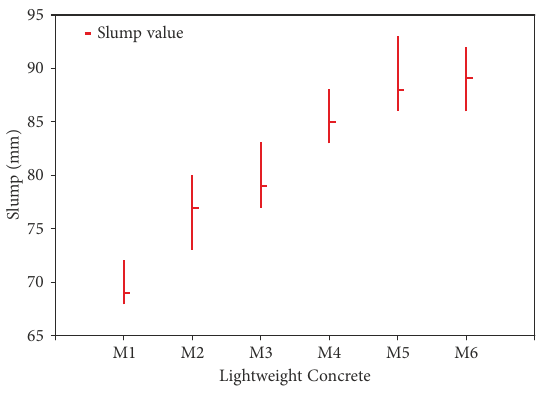
Fig. 1. Workability of Lightweight Concrete Mixes